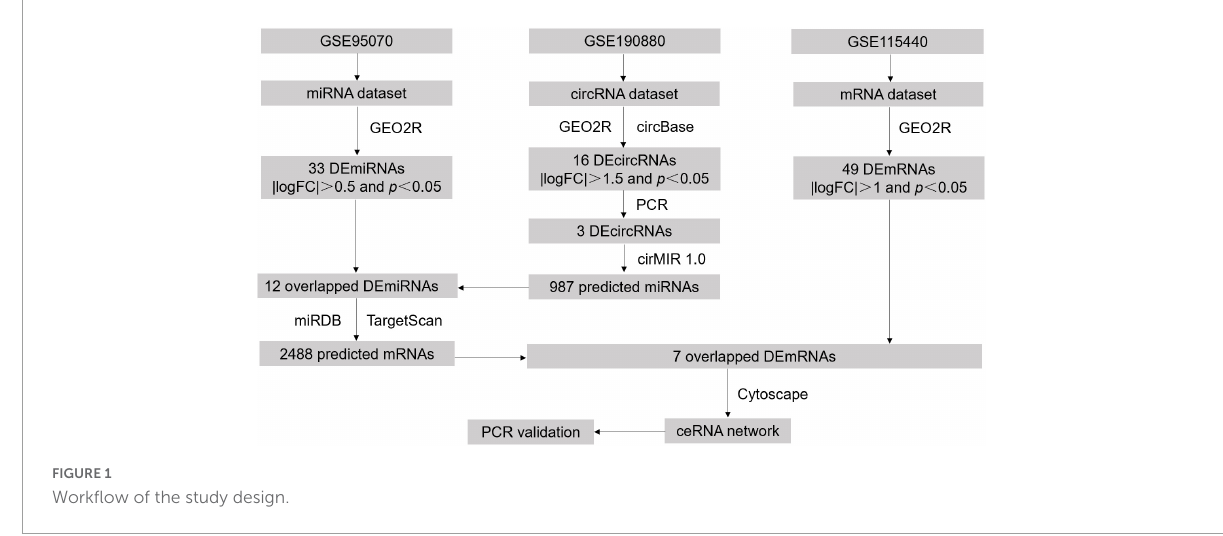
FIGURE1 Workflow of the study design.